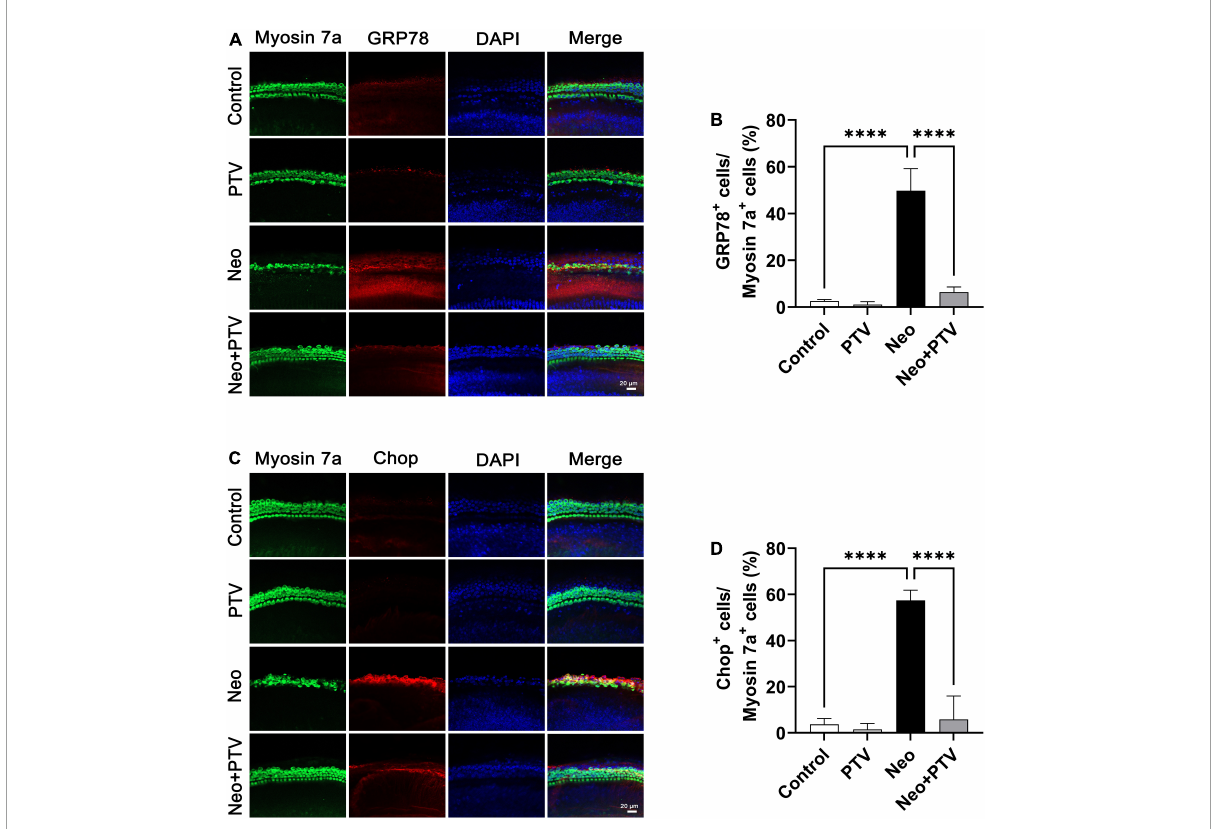
FIGURE5 Impacts of PTV on neomycin-triggered ER stress in cochlear hair cells. (A) Immunostaining with myosin 7a and GRP78 in middle turns in cochlear explants. Scale bars = 20 µ m. (B) Statistics of the proportions of GRP78 highlighted hair cells in (A) . (C) Immunostaining with myosin 7a and CHOP in middle turns in cochlear explants. Scale bars = 20 µ m. (D) Statistics of the proportions of CHOP highlighted hair cells in (C) . ∗∗∗∗ p <